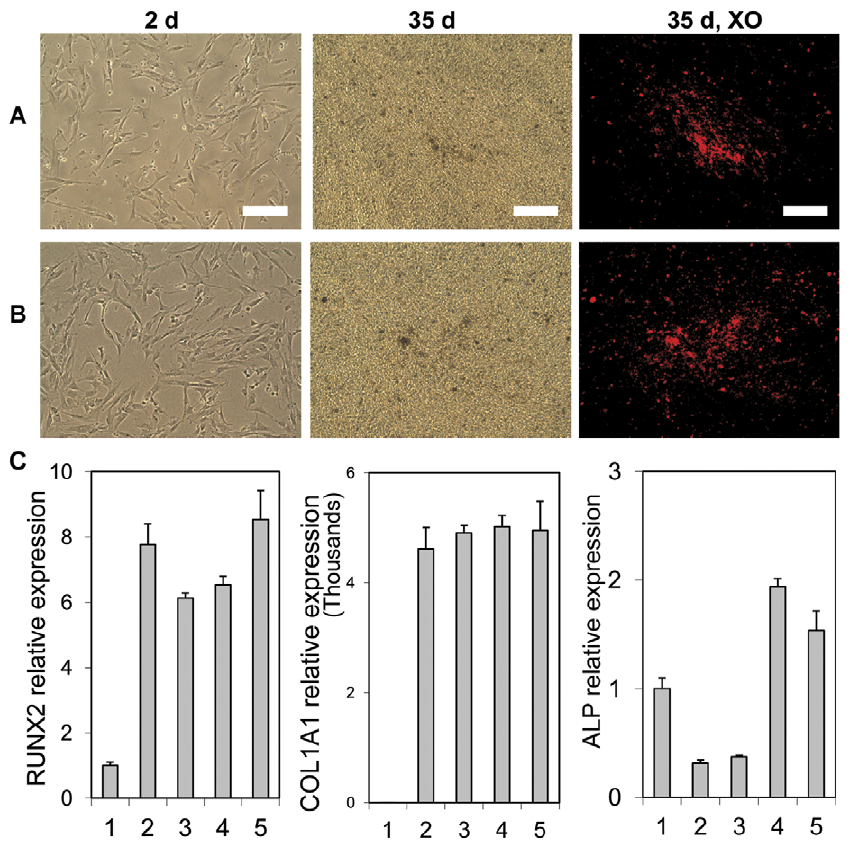
Figure 4. Invitro osteogenic differentiation. Phase contrast images of the cells in the osteogenic cultures on day 2 and 35. (A) and (B) show MSC-like cells derived from H9-hESC and YK26-iPSCs, respectively. The 35 day cultures were stained with xylenol orange dye (XO) to reveal mineral deposition. The red fluorescence in the last column of images displays the positive XO staining. Scale bars: 0.2 mm. (C) RT-qPCR analysis for the mRNA expression of osteogenic-related genes including RUNX2, COL1A1 and ALP on day 35. 1: undifferentiated H9-hESC; 2 and 3: MSC-like cells that derived from H9-hESC and YK26-iPS cells, respectively, before osteogenic differentiation; 4 and 5: 35 day osteogenic cultures of the MSC-like cells derived from H9-hESC and YK26-iPS cells, respectively.